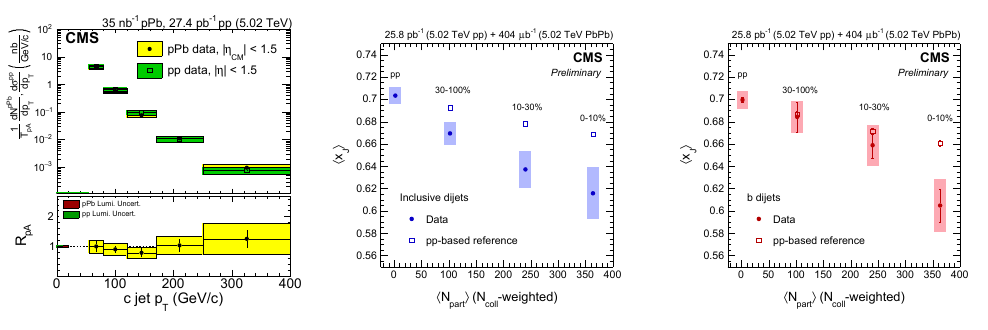
Figure 1. Left: R AA of prompt J /ψ mesons as a function of the number of participants to the collision, at √ s NN = Figure 2. Left: di ff erential cross section for c-jet production in pp and pPb collisions at √ s NN = 5 . 02TeV, as a 2 . 76 [2] and 5.02TeV [3]. Center: v 2 of prompt J /ψ mesons as a function of p T , at √ s NN = 2 . 76TeV, compared function of p T [9]. The R pPb is also shown in the bottom panel. Center: dijet momentum imbalance of inclusive to that of other hadrons. Right: R pPb of prompt ψ (2 S ) [4] and prompt J /ψ [5] mesons at √ s NN = 5 . 02TeV, as a dijets in pp and PbPb collisions at √ s NN = 5 . 02TeV, as a function of the number of participants weighted by the function of rapidity in the centre-of-mass frame. number of binary collisions [10]. Right: same as center, for b